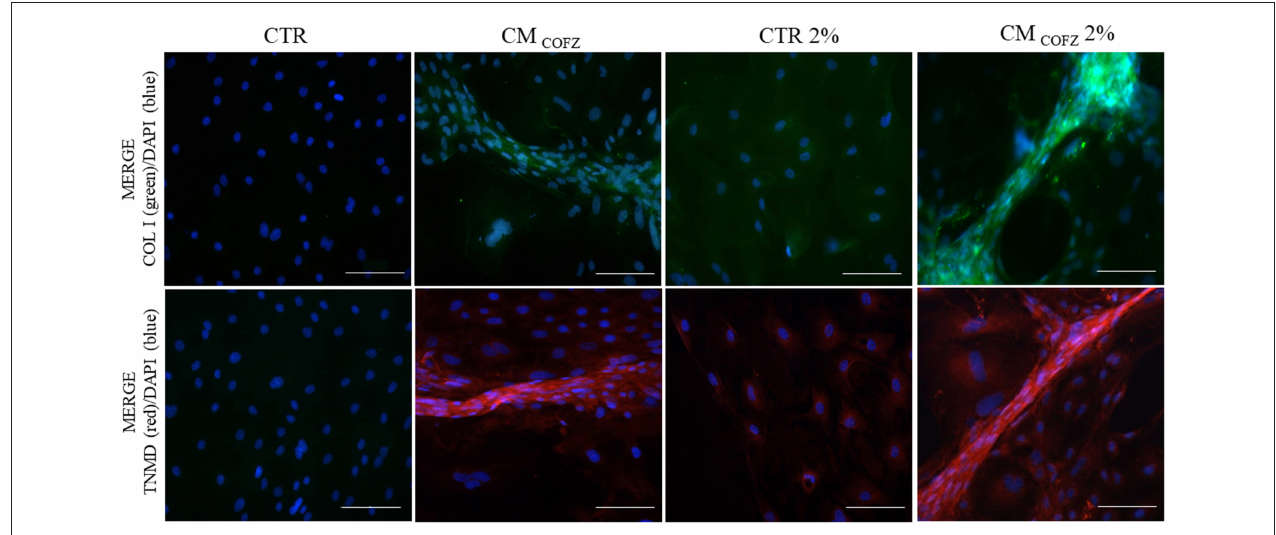
FIGURE 7 | Representative IHC images of COL I (green color) and TNMD (red color) proteins expression in AECs under normoxia and physoxia experimental conditions. Nuclei were counterstained with DAPI (blue color). Magnification 20X, scale bar: 100 µ